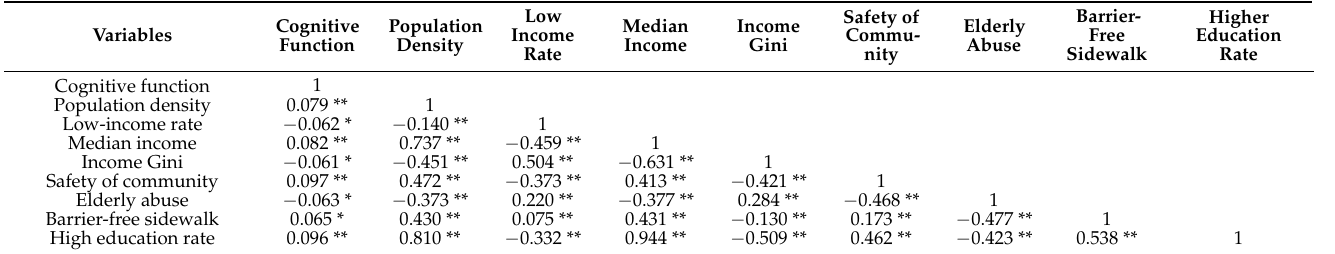
Table 3. Correlation matrix of cognitive function score with area-level indicators.